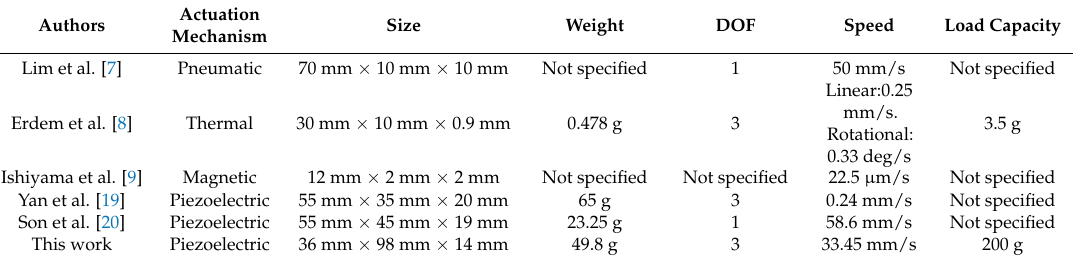
Table 1. The comparison of mentioned